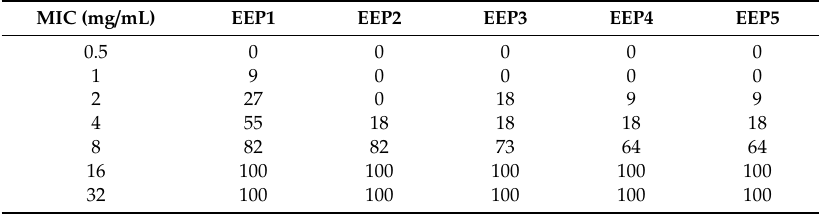
Table 5. Percentage of antibacterial activity (A